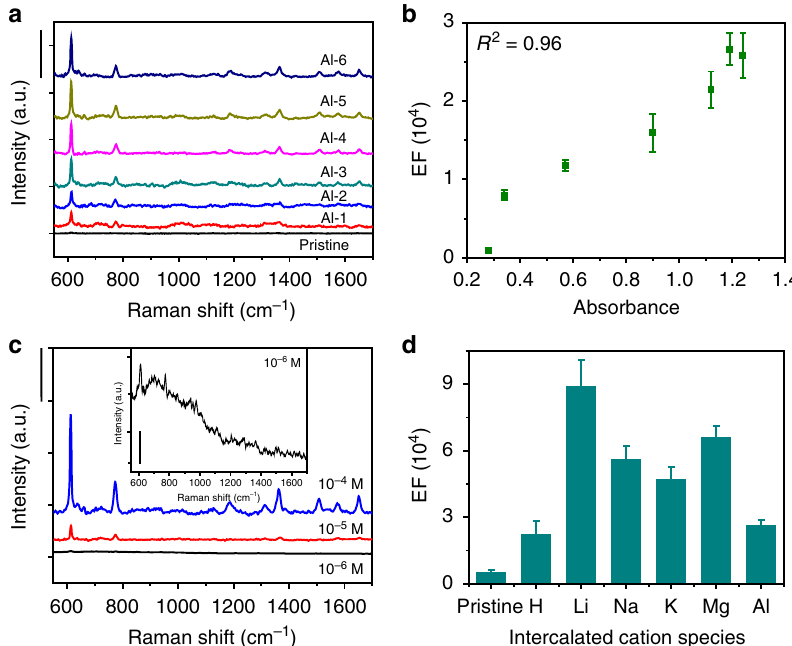
Fig. 2 Colored tungsten oxide fi lm as surface-enhanced Raman scattering (SERS) substrate. a Raman intensity of rhodamine 6G (R6G) (10 − 4 M) on